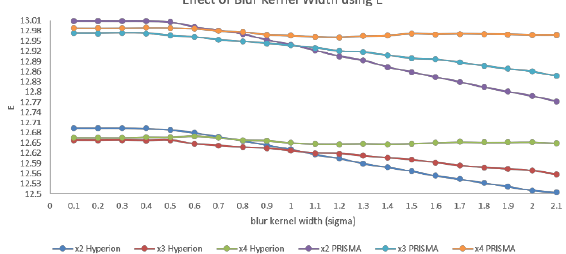
Figure 15. Effect of Blur Kernel Width Using E on GPR’s Performance E values for both PRISMA and Hyperion show a similar pattern except the values being lower in case of Hyperion due to more number of bands (128) than the PRISMA data (112). Again σ = 0.1 shows the highest E for each SF irrespective of the dataset Higher information preservation is visible in GPR compared to